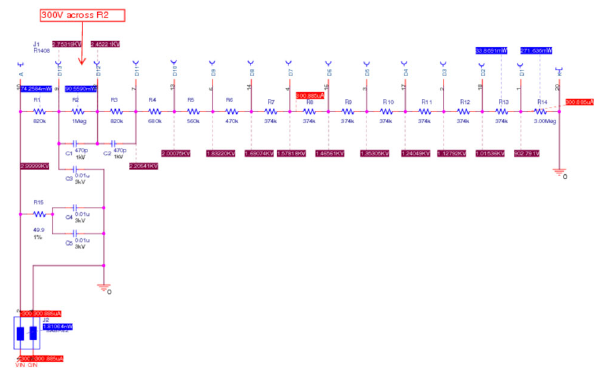
Fig. 18 Schematic diagram of the inner veto PMTs’ base circuit